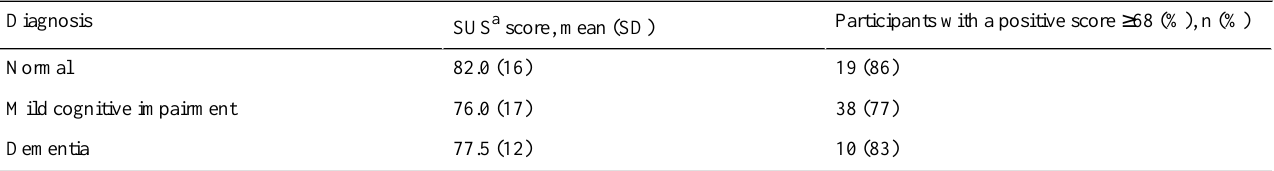
Table 4. System usability results from the System Usability Scale